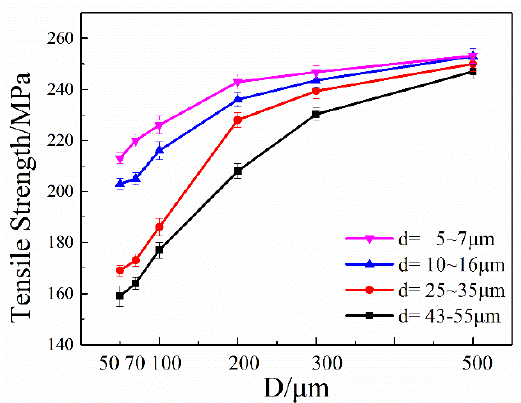
Figure 2. Tensile strength of specimens with different specimen and grain sizes (wire diameter: 50 ~500 μm, grain size: 6.5 ~ 50 μm).